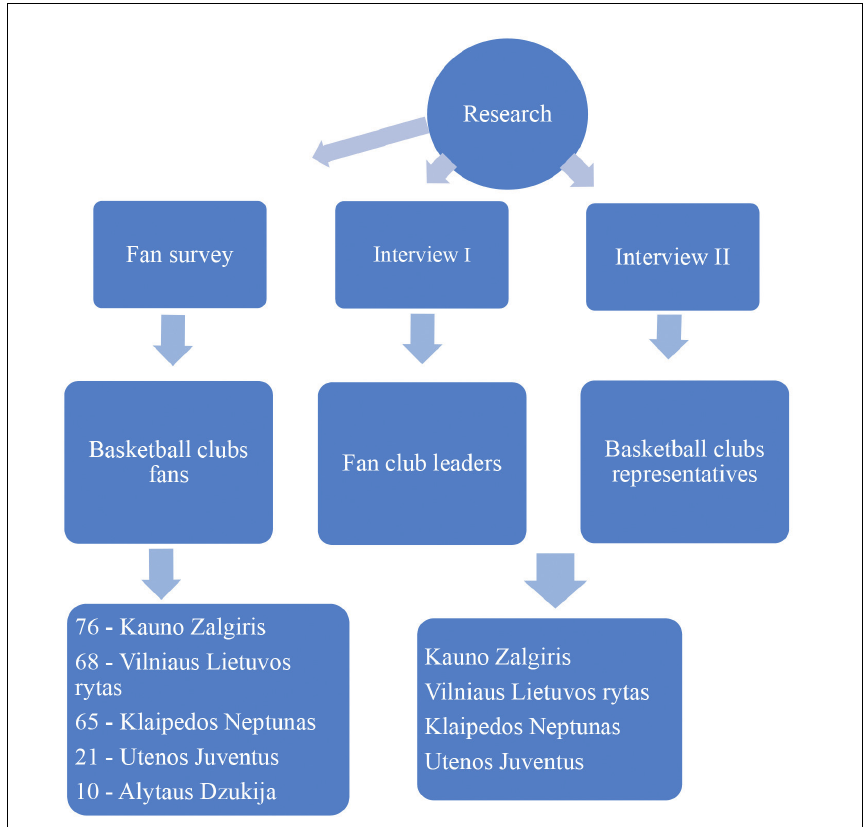
Figure 3. Study structure